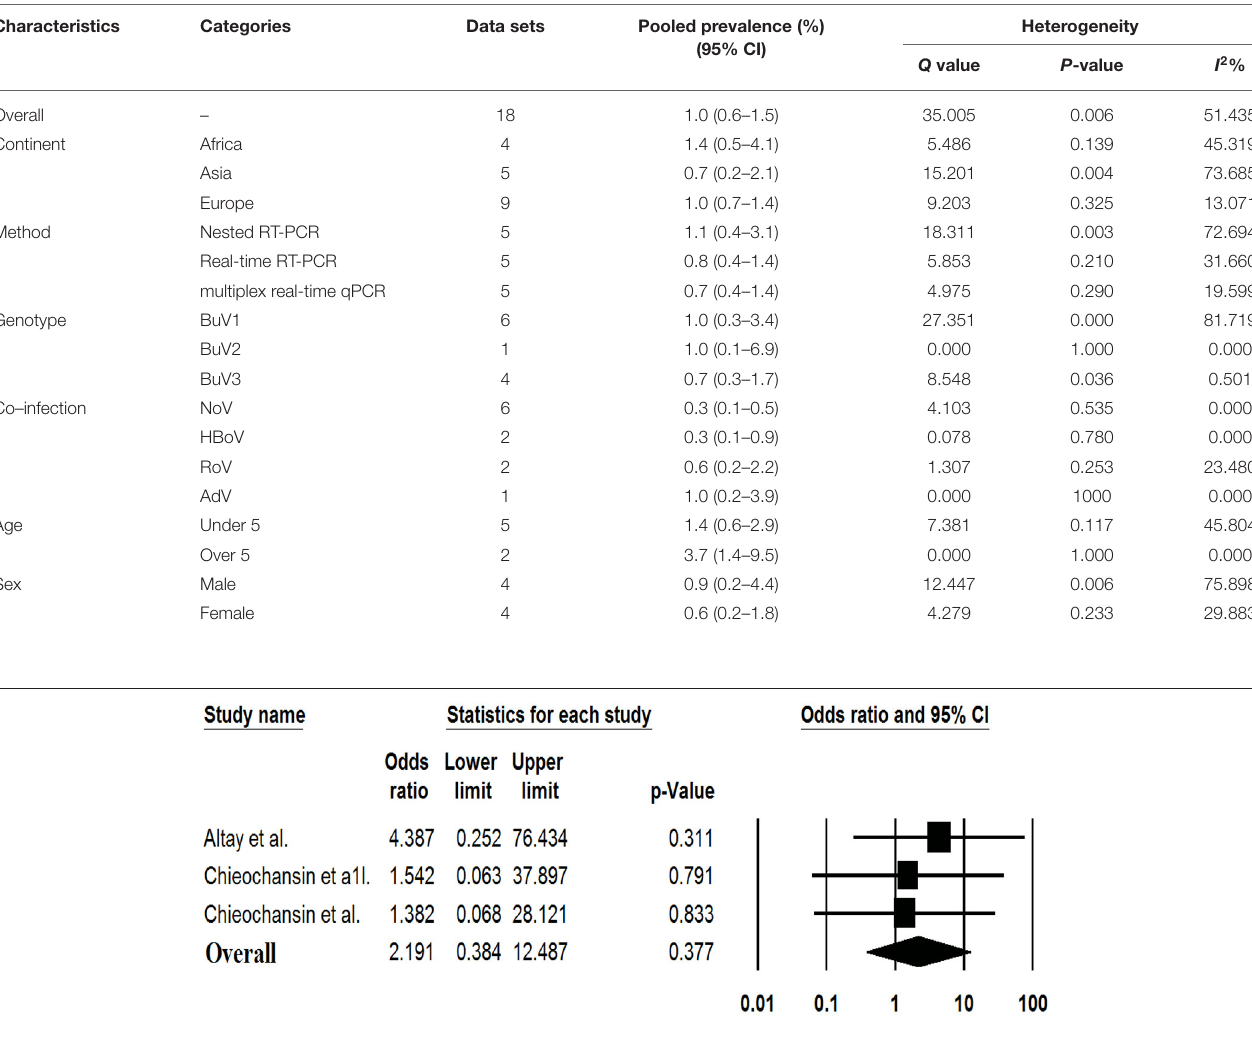
TABLE 4 | The Bufavirus prevalence based on subgroups and studies heterogeneity. Characteristics